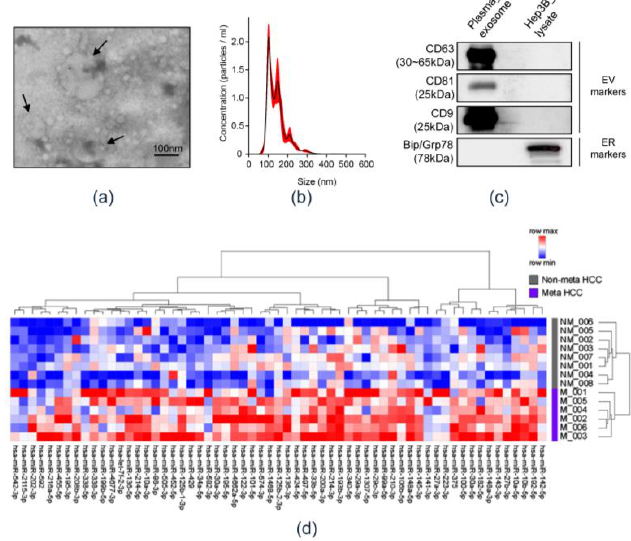
Figure 2. Confirmation of isolated circulating exosomes and identification of overexpressed exo-miRs in the metastasis group. ( a ) Transmission electron microscopic observation of separated circulating exosomes obtained from patients with hepatocellular carcinoma. Arrows indicate exosomes. Scale bar = 100 nm. ( b ) Nanoparticle tracking analysis (NTA) size distribution and concentration of exosomes. ( c ) Western blot analysis. Plasma exosomes were positive for exosome markers (CD63, CD81, and CD9) and negative for Grp78. Hep3B lysate was used as a negative control. ( d ) Heatmap of the di ff erentially expressed 61 exo-miRs in accordance with the metastasis status. NM, non-metastasis; M,